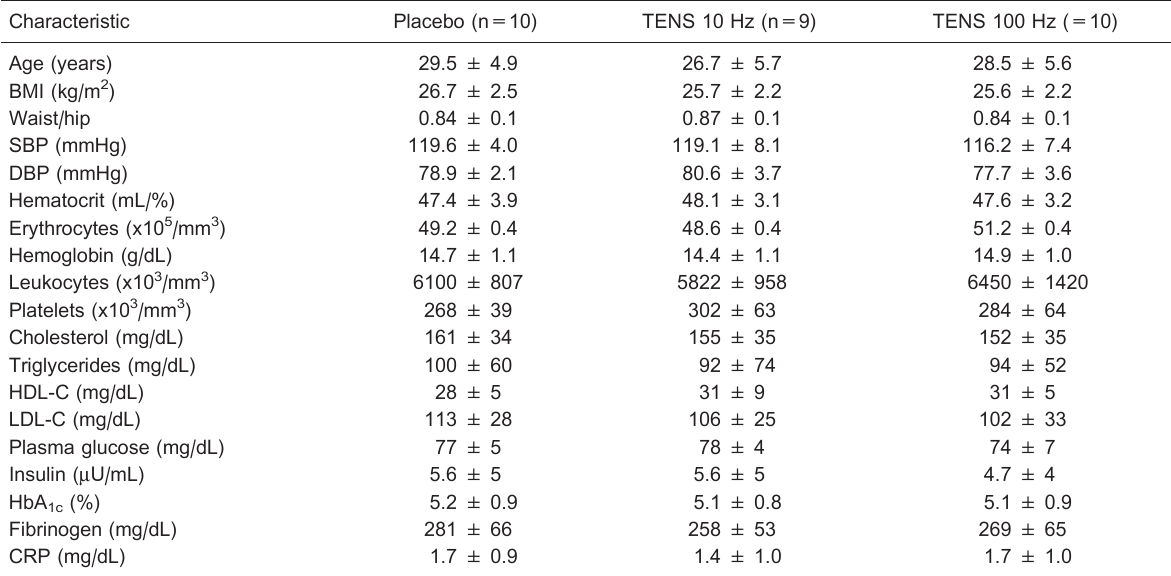
Table 1. Clinical and metabolic characteristics of the studied